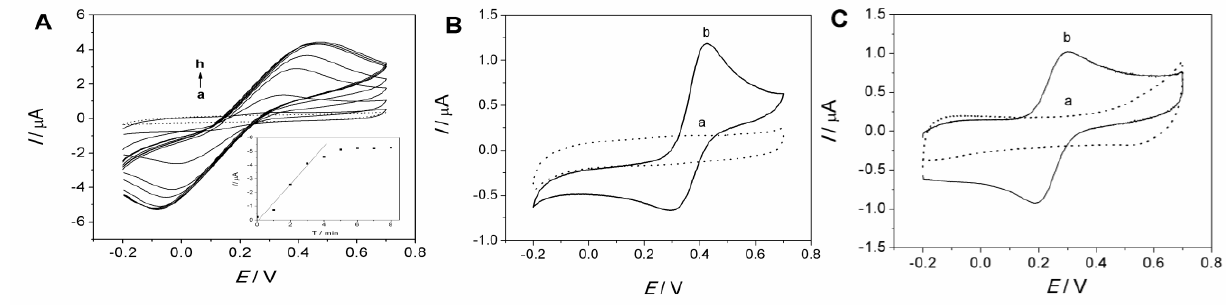
Figure 3. ( A ) Cyclic voltammograms (CVs) of MCF-IL/PVA electrode dipping in 1 × 10 − 4 mol/L Fe(CN) 63 − solution scanned at every minute. Inset: plots of I pc versus immersion time; ( B ) CVs of (a) MCF-IL/PVA electrode and (b) MCF-IL-Fe(CN) 63- /PVA electrode obtained in 0.1 M HCl + 0.1 M KCl solution and ( C ) that in 0.1 M PBS + 0.1 M KCl (pH = 7.0). Potential range: −0 .2 V~0.7 V; scan rate: 100 mV s −1 .